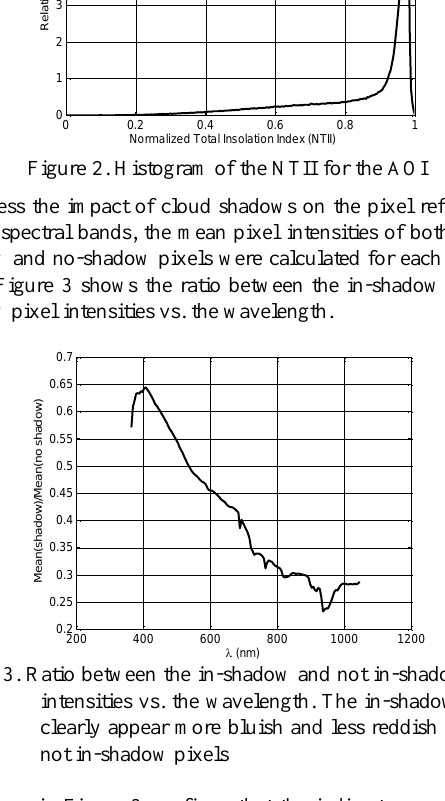
across spectral bands.